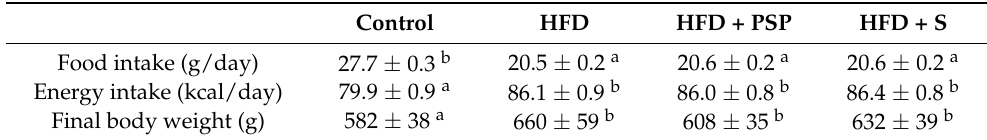
Table 1. Effects of PSP on food intake, energy intake and body weight in Sprague Dawley rats exposed to HFD 1 .